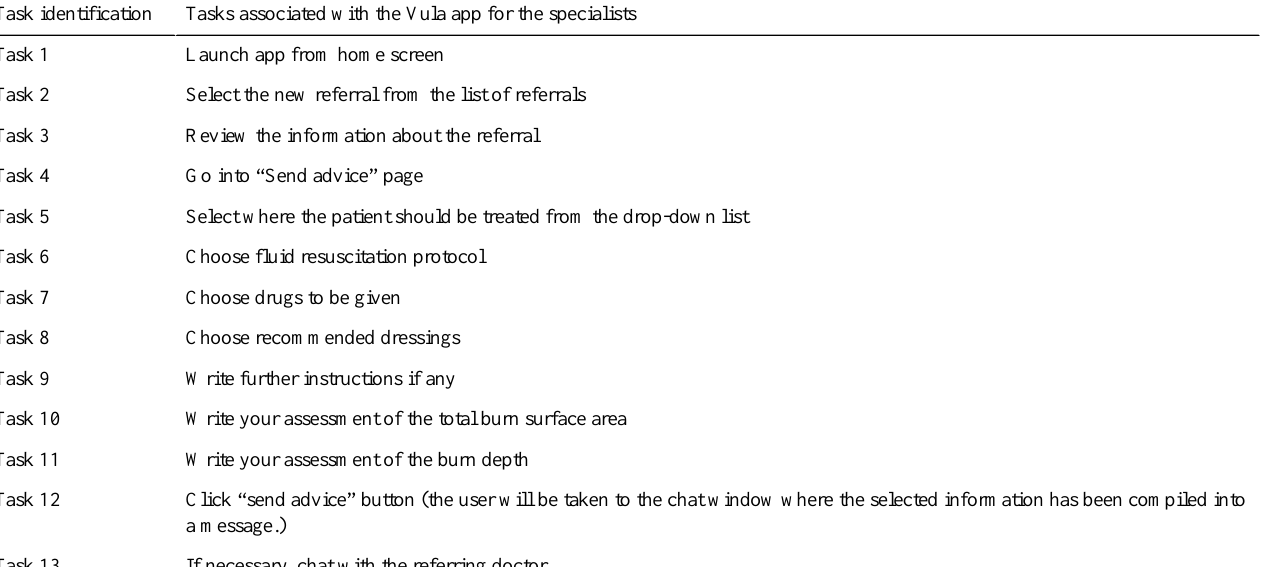
Table 2. Tasks associated with the Vula app for burns specialists. Tasks associated with the Vula app for the specialistsTask identification